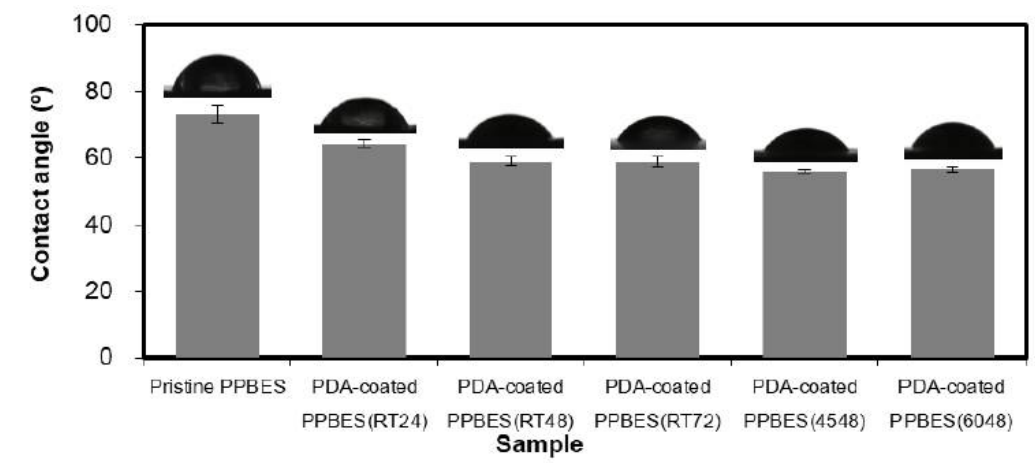
Figure 4. Water contact angles of pristine and PDA-coated PPBES prepared under different reaction conditions. PDA-coated PPBES(RT24) means that PDA coating was performed at room temperature